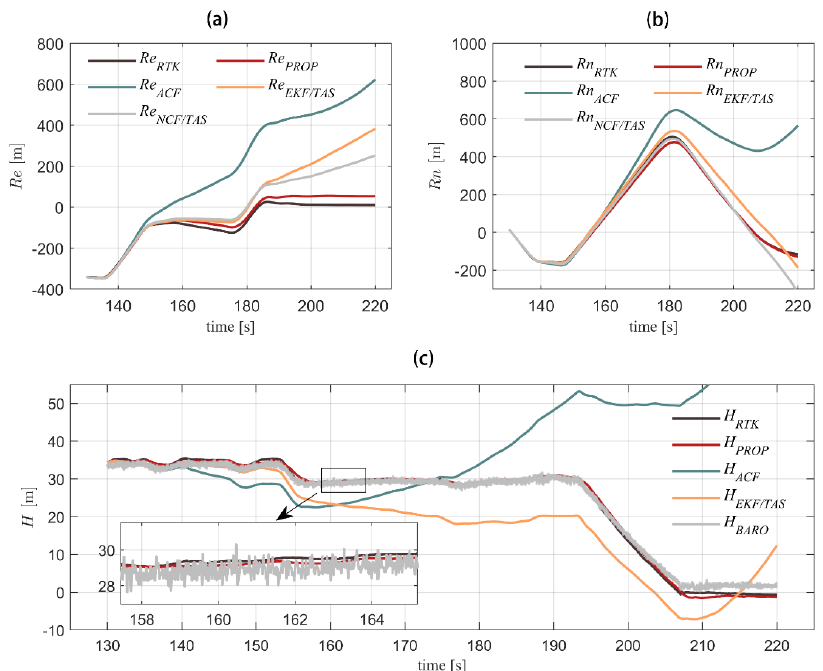
Figure 9. Three-axis position solution of five algorithms in flight is shown for east position, north position, and altitude (from ( a – c ), respectively). In order to find difference of horizontal position, NCF/TAS and what we proposed use the same height model, so the curve of NCF/TAS is not drawn in the figure ( c ).